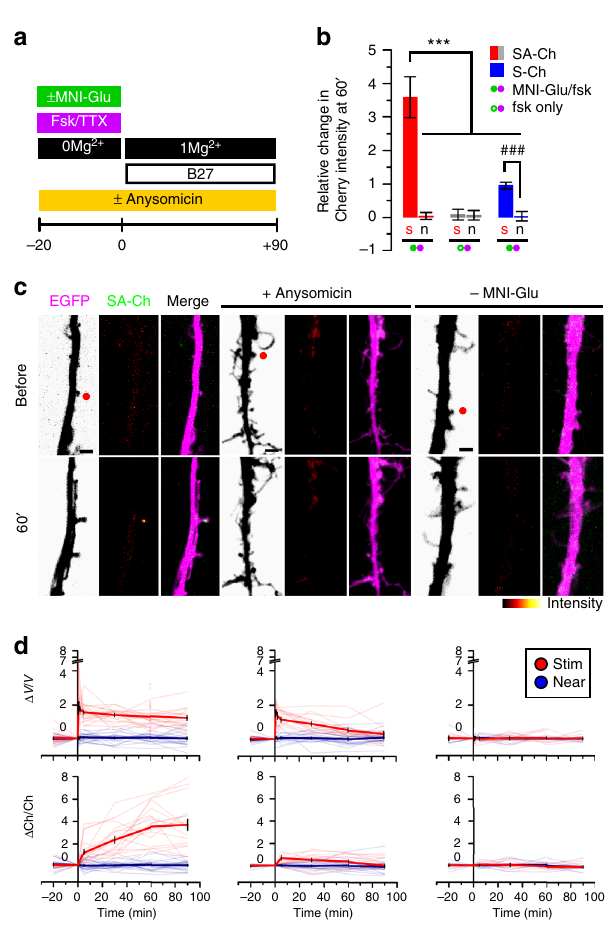
Fig. 3 Synapse speci fi city of SA-Ch expression at potentiated synapses. SA- Ch is speci fi cally expressed at potentiated synapses. DIV 8-10 neurons were focally stimulated by uncaging glutamate in close proximity to selected spines. a Neurons were maintained in standard Mg 2+ -free ACSF in the presence of forskolin and TTX for 20 min before uncaging with or without MNI-caged glutamate. Following two-photon uncaging, medium was changed to 1 mM Mg 2+ ACSF supplemented with B27. b Local release of glutamate stimulates SA-Ch translation at stimulated (s), but not nearby (n) spines. This effect was speci fi c to glutamate release, as it was absent when MNI-glutamate was not added to the medium. Following stimulation, S-Ch change was much lower and is an effect of spine enlargement. *** P < 0.001, one-way ANOVA, Bonferroni comparison of means. ### P < 0.001 unpaired samples Student ’ s t -test, two-tailed. Bars are mean ± SEM. c Translation inhibition with anysomicin blocked SA-Ch accumulation at stimulated synapses. Representative images of stimulated dendrites in neurons transfected with SA-Ch. Red dots in the EGFP channel indicate the location of two-photon uncaging. Experimental conditions are indicated on top of images. Scale bar, 2 μ m. d Time course of relative changes in volume ( Δ V / V , top graphs, measured by the EGFP intensity) and SA-Ch intensity ( Δ Ch/Ch, bottom graphs) following uncaging of stimulated (red) and near spines (blue). Stimulation induced a long-lasting volume change, paralleled by a slowly rising accumulation of SA-Ch; in the presence of anysomicin, volume change was transient and no accumulation of SA-Ch was evident. Bold lines represent mean ± EM, whereas narrow lines are single traces for depicted data for stimulated (light red) and nonstimulated (light blue) spines. d Corresponding conditions in c above: from left to right, samples with MNI-Glu/forskolin, MNI-Glu/forskolin/ anysomicin, forskolin only/no MNI-Glu. Open circles are corresponding Δ V / V values at 60 min for SA-Ch spines in